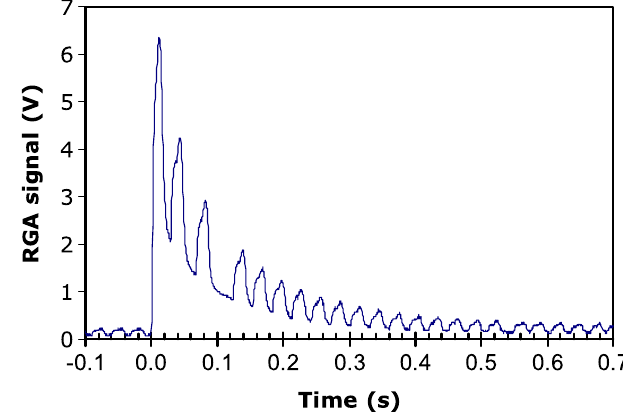
FIG. 4. (Color) Fast RGA signal from the RGA-300 for amu (cid:9) 2 (hydrogen).